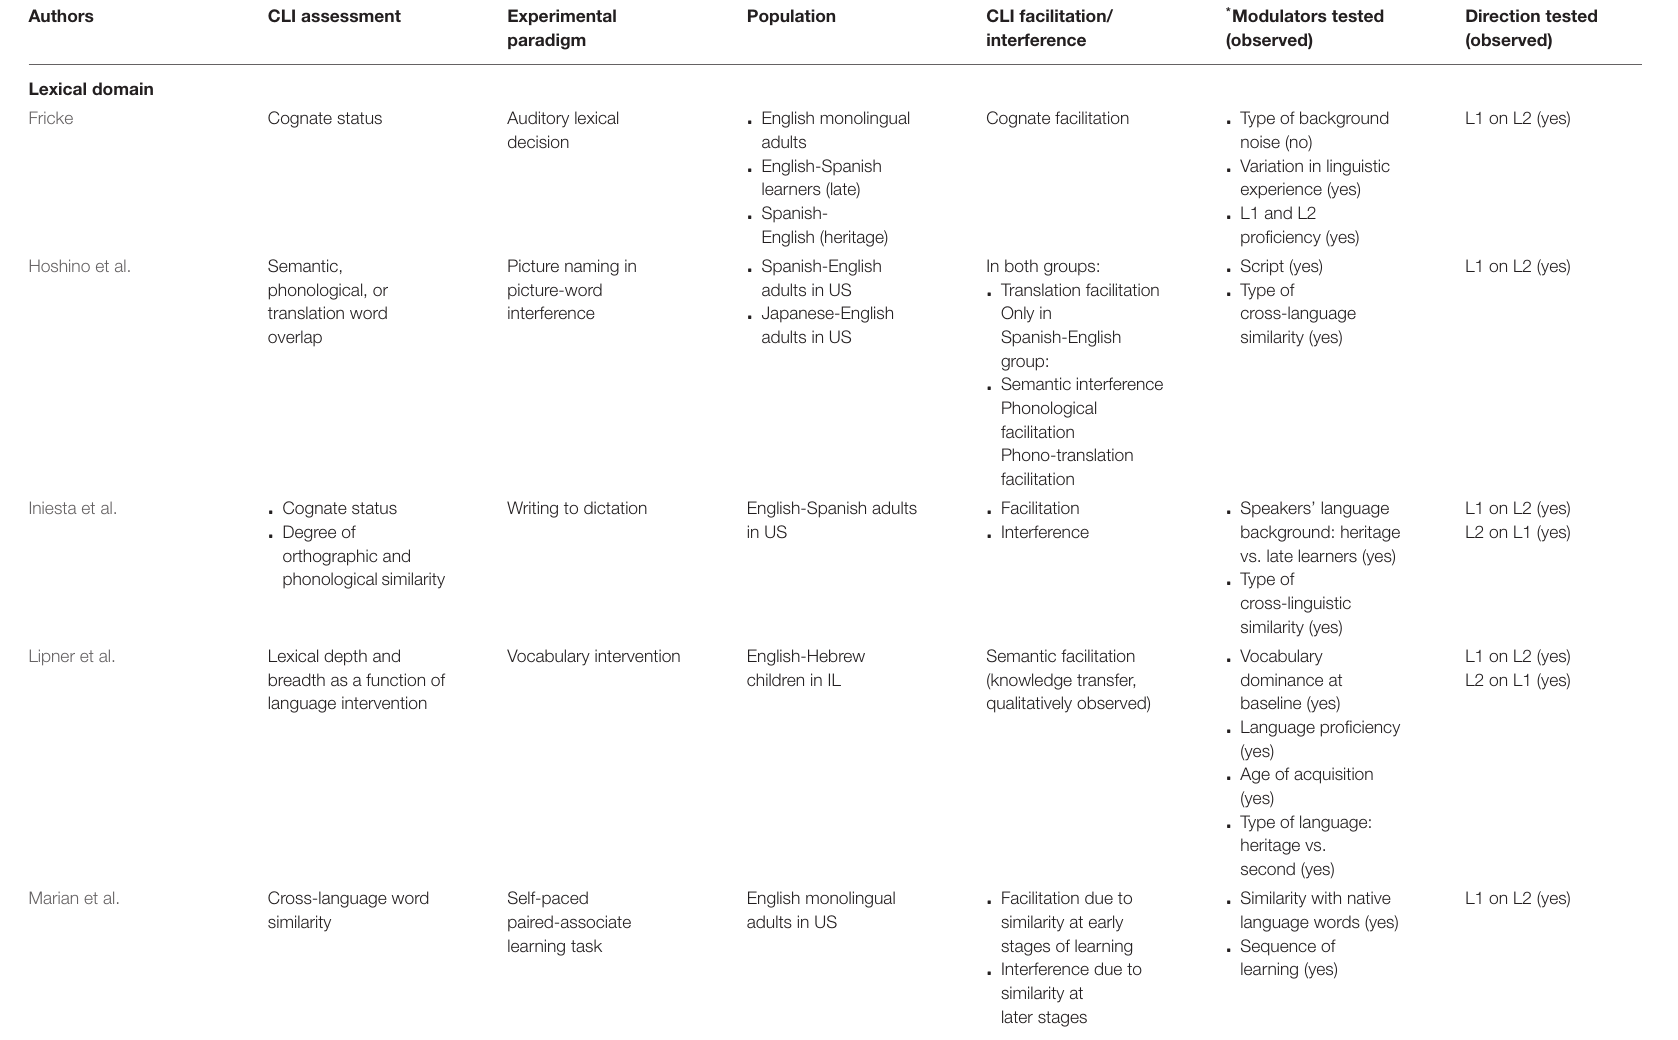
TABLE 1 | Overview of studies in the Research